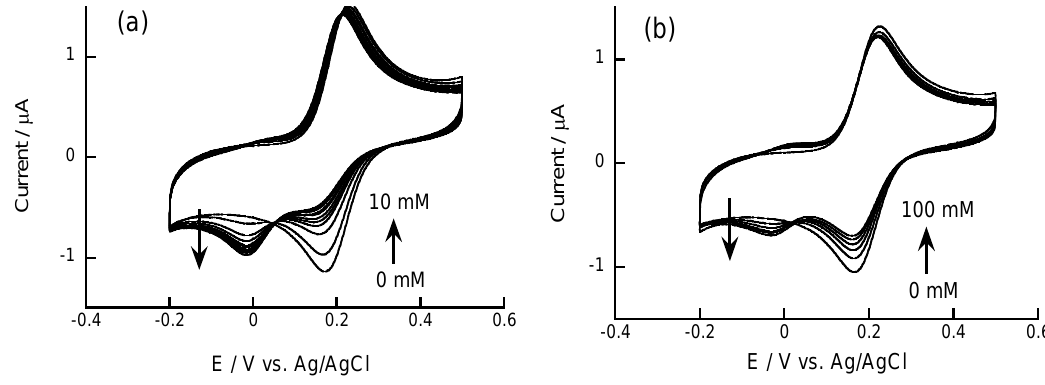
Figure 3. Cyclic voltammograms of 0.1 mM FcBA in the presence of ( a ) fructose and ( b ) glucose at pH 7.0. Scan rate: 50 mV·s −1 . Reprinted with permission from Takahashi et al . [9]. Copyright (2011) Elsevier.